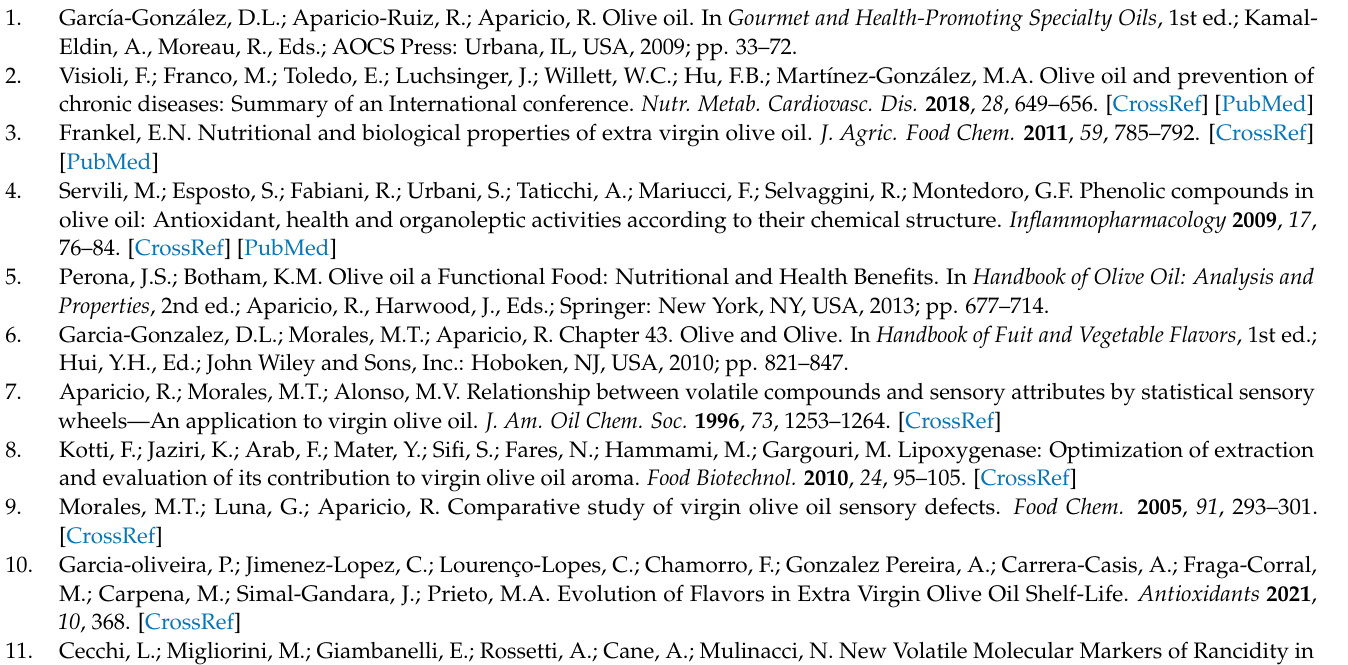
Figure S4: Spider chart evolution of the sensory attributes evaluated during six month stored of virgin olive